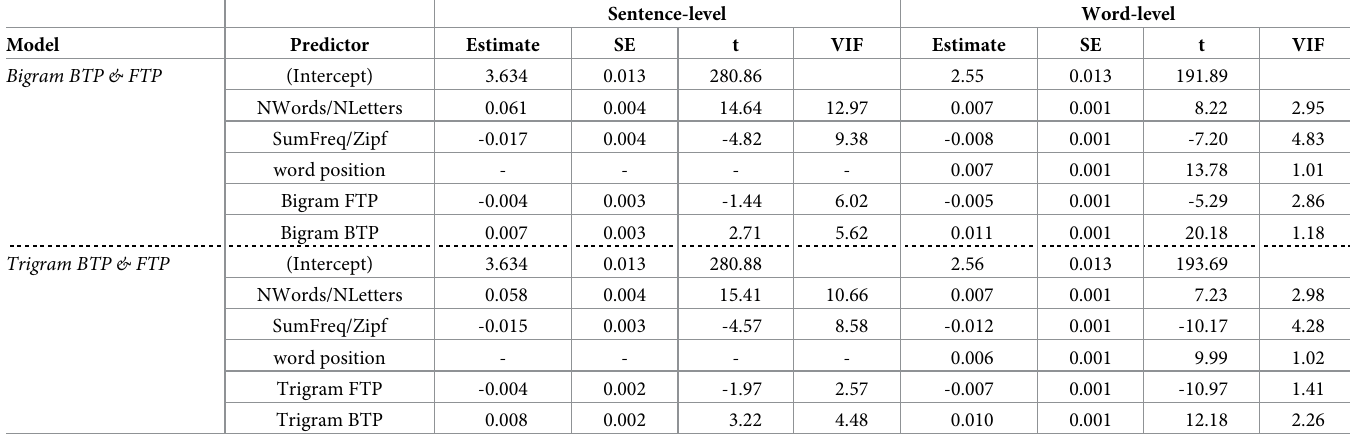
Table 6. Results of the mixed-effects models concerning transitional probability (TP).